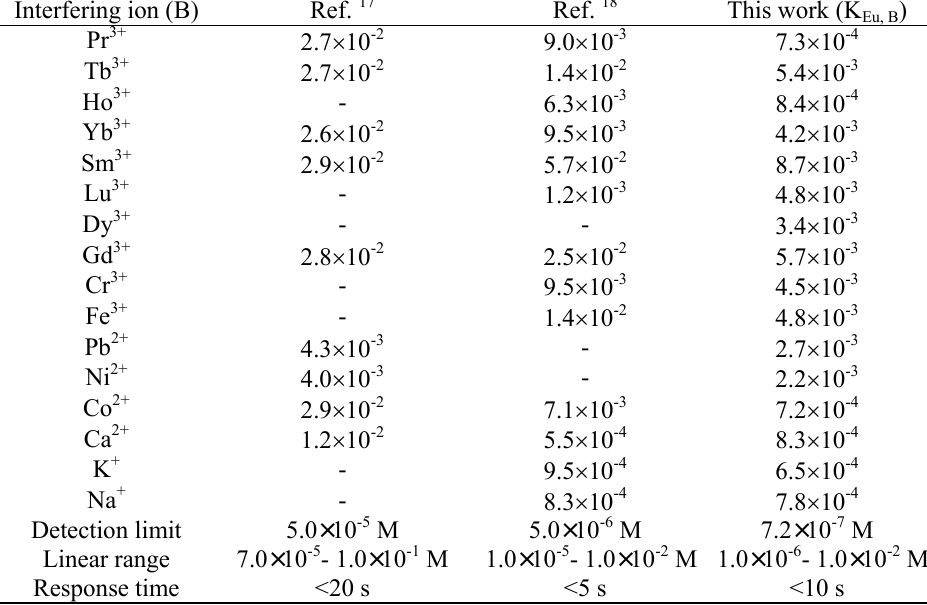
Table 2. Comparison of selectivity coefficients, detection limit, response time and linearity range of the developed Eu 3+ sensor and the formerly mentioned Eu 3+ ion-selective